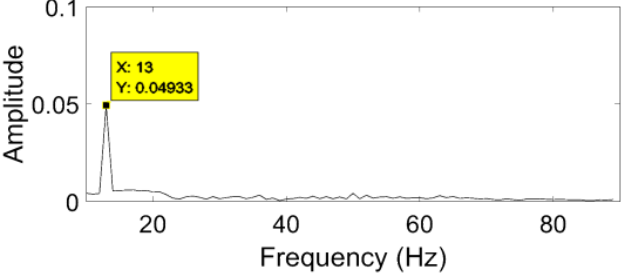
Figure 36. FFT analysis of i gd in PI control system.